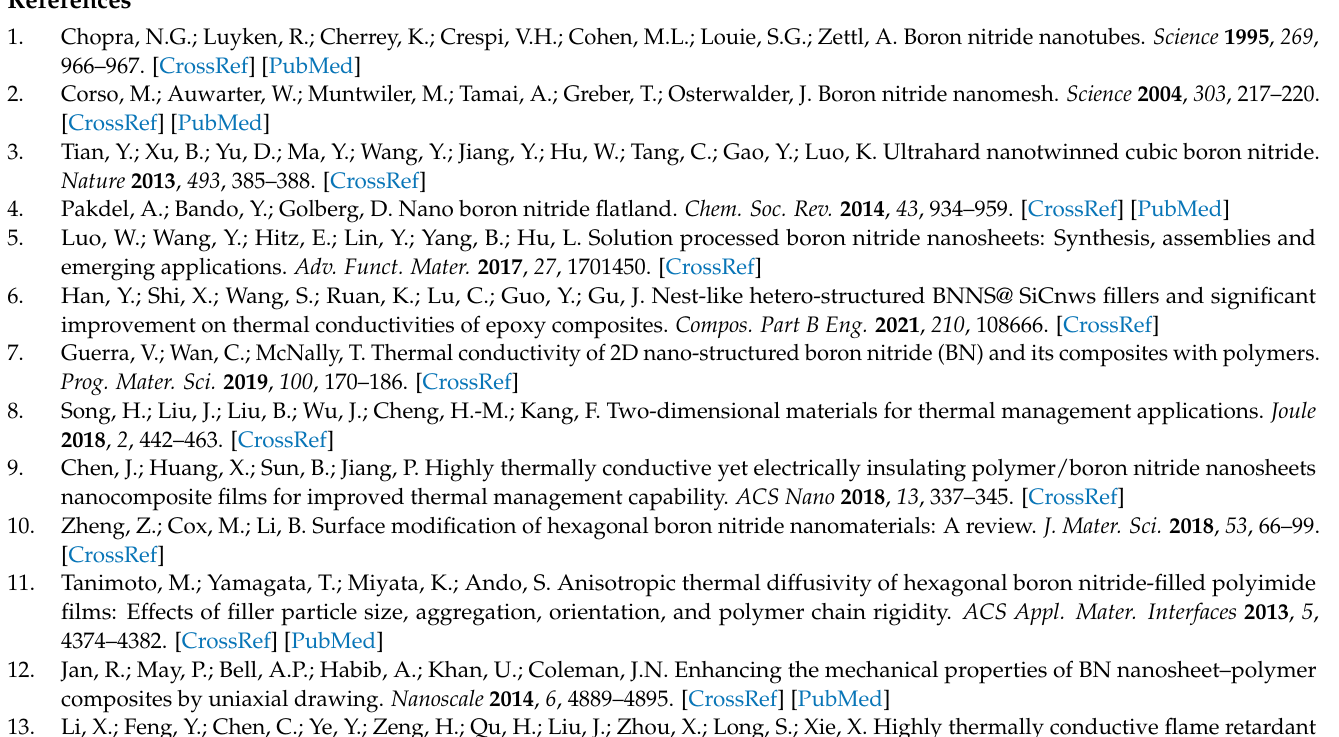
Table S3. The contact angles of PBE nanocomposites. Table S4. Thermal conductivity parameter of PBE